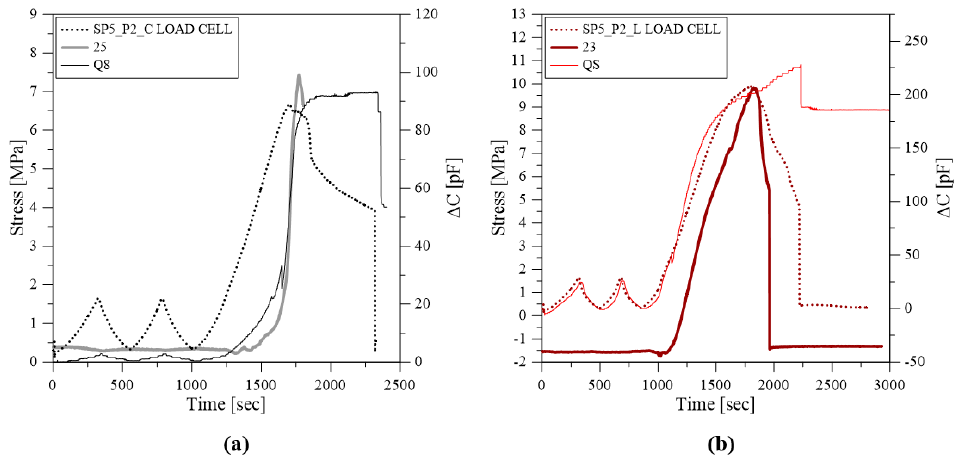
Figure 19. Comparison between measurements provided by ceramic and capacitive sensors and the load cell data, for post-installation system P2: ( a ) calcarenite masonry; ( b ) clay brick